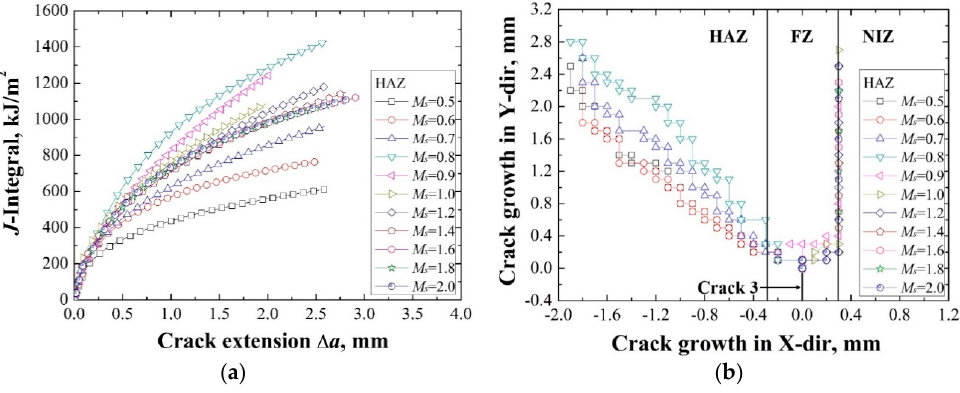
Figure 5. The J–R curves ( a ) and the crack growth paths ( b ) at different strengths of HAZ.